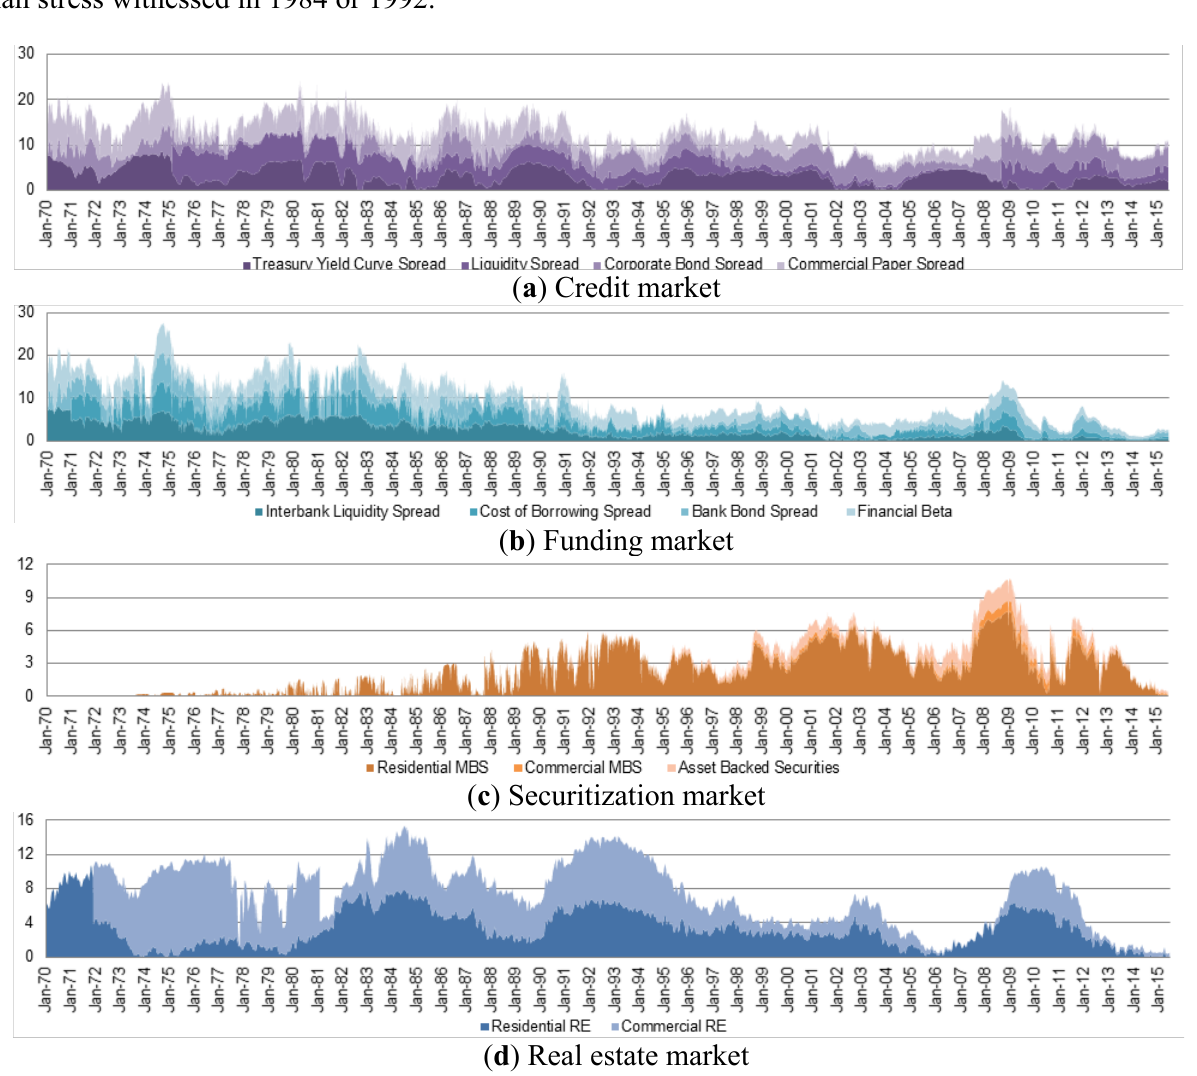
Figure 5. Financial stress in the credit ( a ); funding ( b ); securitization ( c ); and real estate ( d ) markets in terms of their constituent